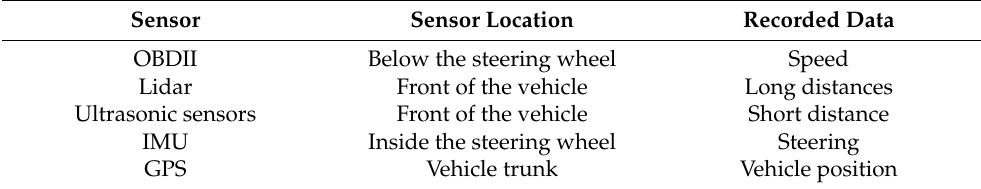
Table 1. Sensors, recoded parameters, and location.